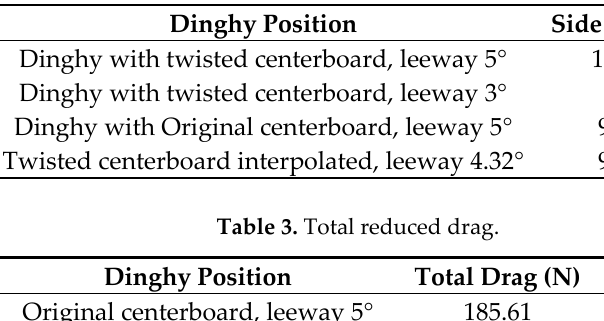
Table 2. Side forces for different dinghy leeway angles.